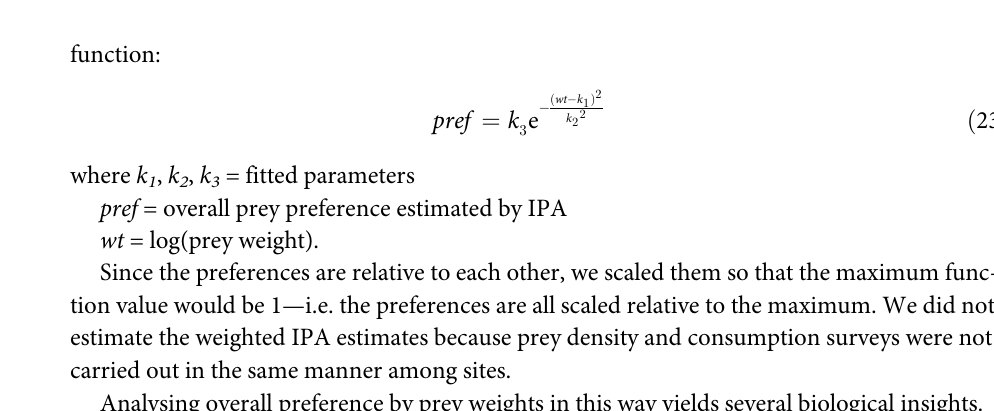
Fig 3. Weighting can increase precision of IPA estimates. Precision of weighted bootstrapped estimates of IPA are compared to unweighted estimates for simulated data. Smaller values mean a greater precision. Confidence intervals were estimated by bootstrapping 100 replications of each combination of parameters. Confidence interval width for the weighted estimate is divided by that for the unweighted—thus, values < 1 mean that precision of weighted is greater than the unweighted.